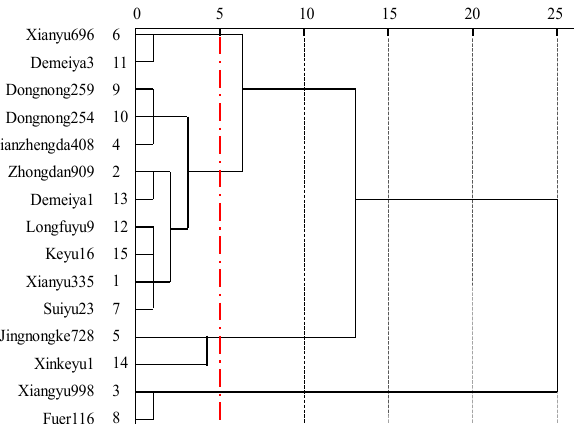
Figure 2. Dendrogram of cluster analysis of the maize seeds of 15 different varieties: 0–25 indicates the range of Euclidean distance, and different Euclidean distances lead to different categories. The red line in the figure indicates that Euclidean distance 5.0 is selected, and the number of branches passed by the red line represents the clustering results of maize seed varieties.